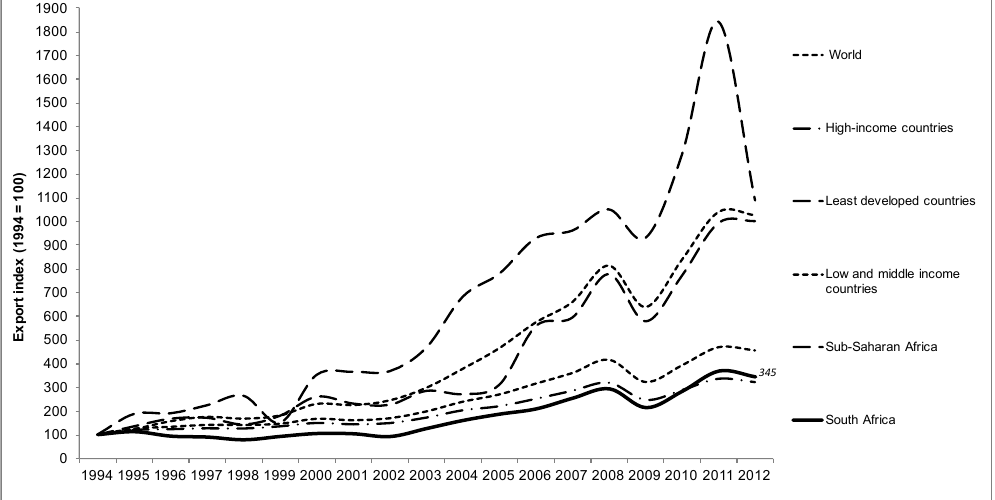
Benchmark of South Africa’s trend in exports (index: 1994 =